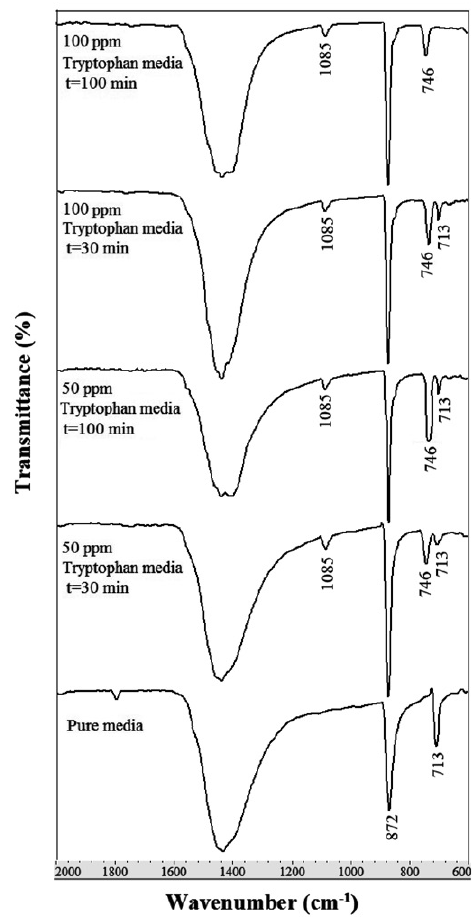
Figure 2. FTIR results for CaCO 3 crystals precipitated in pure me- dia and media supplemented with 50 and 100 ppm